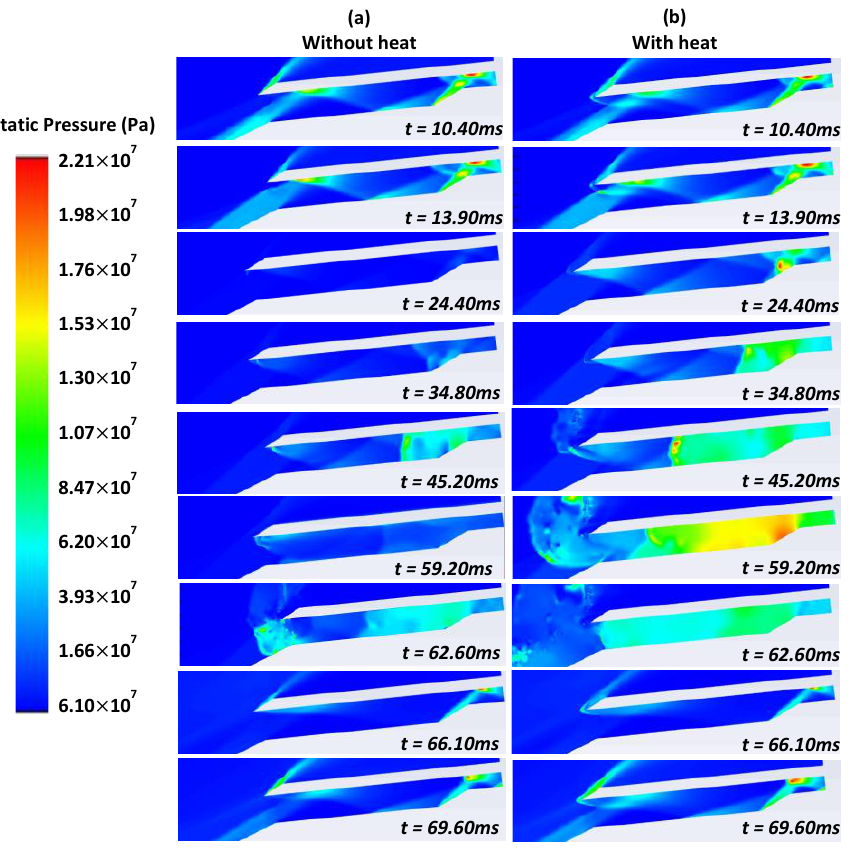
Figure 6. Static pressure of AoA 6 ◦ and TR 0.5 ( a ) without and ( b ) with heat of 1 mm 5 × 10 13 W/m 3 . The pattern in the density contour was readily visible, as is the trend in the FD and TPR data. Figure 7 shows the changes in the FD for varying AoAs across varying heat source diameters and power at a steady state. When the heat source is introduced, the value of FD dropped. As the boundary separation at the isolator entry was controlled, the flow distortion was minimized significantly, which contrasted with the existence of a heat source scenario.